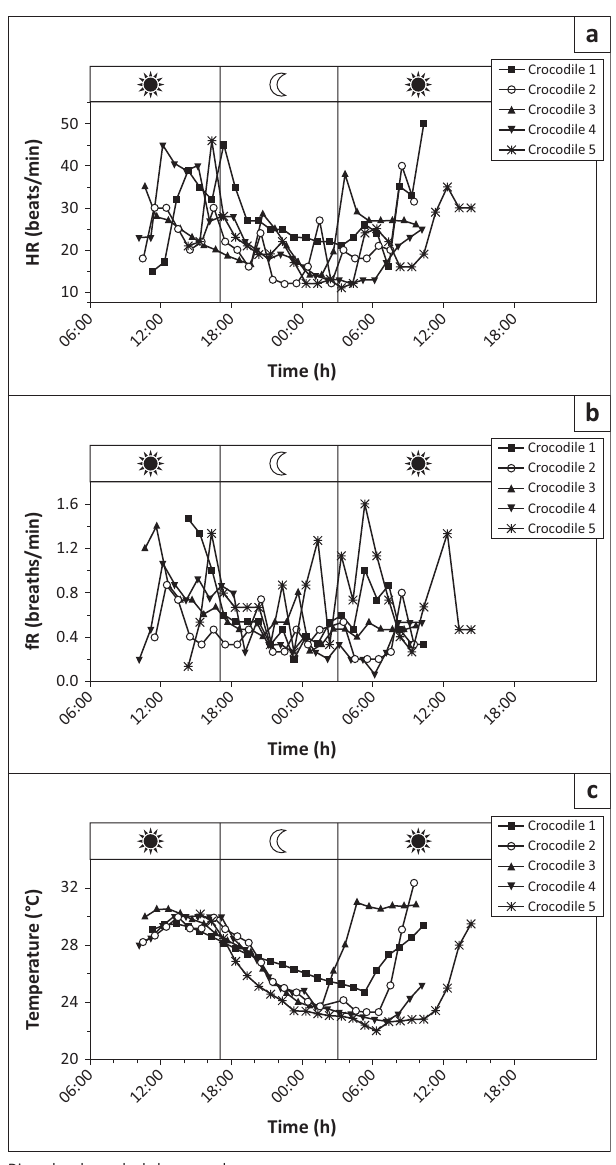
Diurnal cycle marked above graph. FIGURE 1: Graphs of (a) heart rate (beats per min), (b) respiratory frequency (breaths per min) and (c) internal body temperature (°C) of the five crocodiles from anaesthesia to recovery over 24 hours